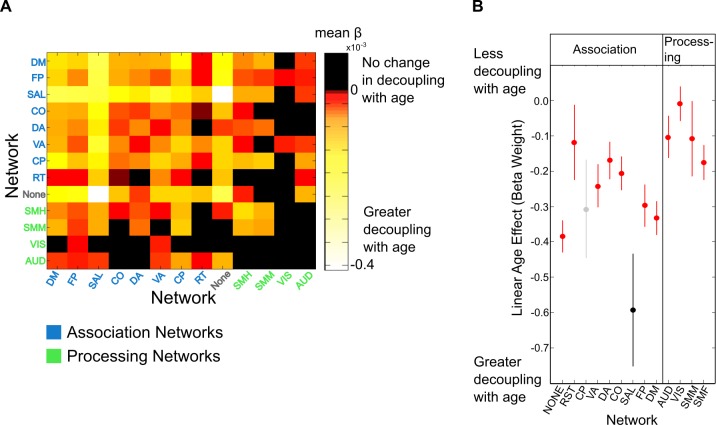
Network changes in phase-locking.(A) Age-related decreases in phase-locking tended to be within and between association networks (e.g., DM, FP, and SAL), while within- and between-network oscillations involving processing networks remained relatively stable. (B) Age-related increases in slow frequency decoupling were greater in association networks than in processing networks (p = 10−9). Oscillations in the SAL network became significantly more decoupled compared to any other association or processing network, with the exception of the CP network (all p < 0.05, corrected). See S1 Data for individual data points. AUD, Auditory; CO, Cinguloopercular; CP, Cinguloparietal; DA, Dorsal Attention; DM, Default Mode; FP, Frontoparietal; NONE, Unknown; RT, Retrospenial Temporal; SAL, Salience; SMH, Somatomotor Hand; SMM, Somatomotor Mouth; VA, Ventral Attention; VIS, Visual.